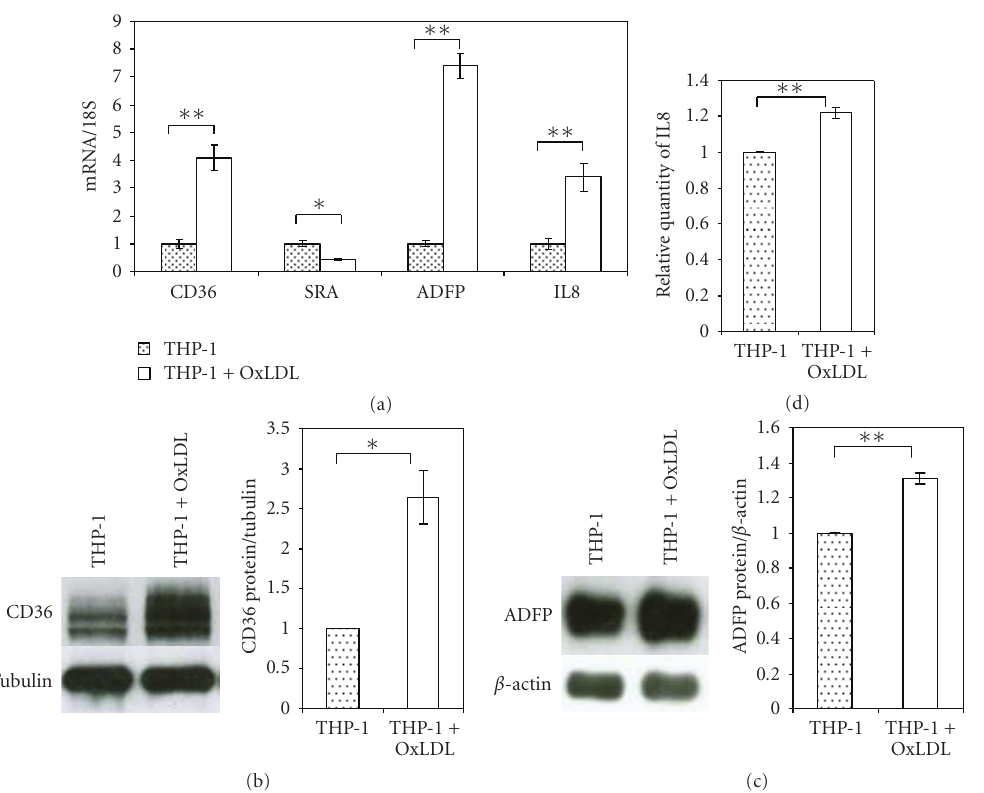
Figure 2: Comparison of gene/protein expression patterns between OxLDL-treated (100 μ g/mL, for 24 hours) and PBS-treated PMA- di ff erentiated THP-1 cells. (a) Real-time quantitative PCR showing gene expression levels for CD36, SRA, adipophilin (ADFP), and IL-8. (b), (c) Western-blot analysis of, respectively, CD36 and ADFP protein expression levels. (d) IL-8 protein levels in THP-1 culture supernatants assayed by ELISA. Treated and untreated cells are, respectively, represented by plain and dotted bars. Bars represent the means ± SE for 3 di ff erent experiments performed in duplicate. Wilcoxon matched pairs test was used to determine significance. ∗∗ P ≤ . 01, ∗ P ≤ .